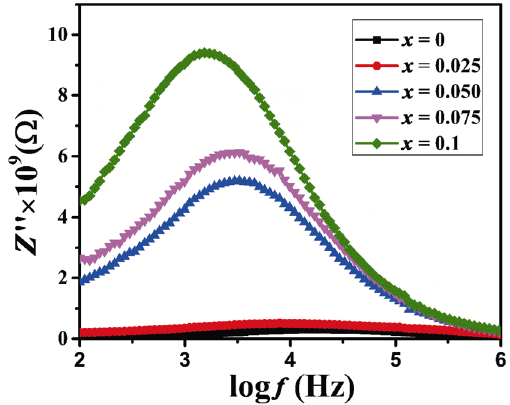
Fig. 12 Variation of imaginary part of impedance of Mn 0.5 Zn 0.5 Gd x Fe 2– x O 4 ( x = 0, 0.025, 0.050, 0.075, and 0.10) with